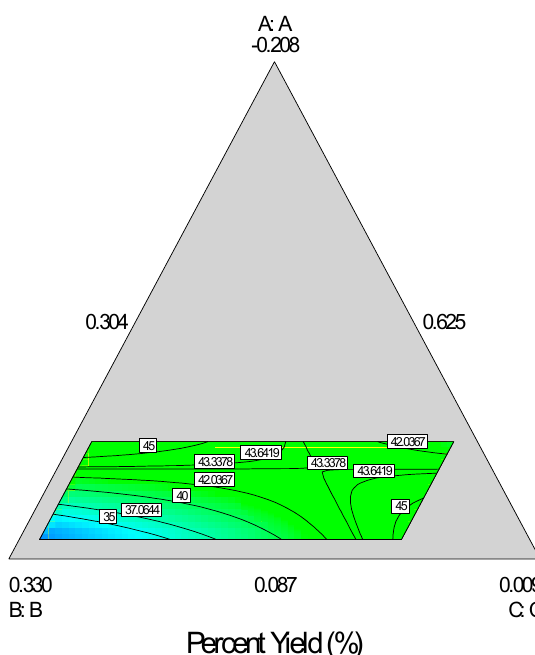
Figure 5. Model graph showing the design space and variation in percent yield as a function of the mixture composition. A = Crosslinking agent; B = Initiators; C = Stabilizer and D = Macromonomer (Polylactide-based nanoparticles).